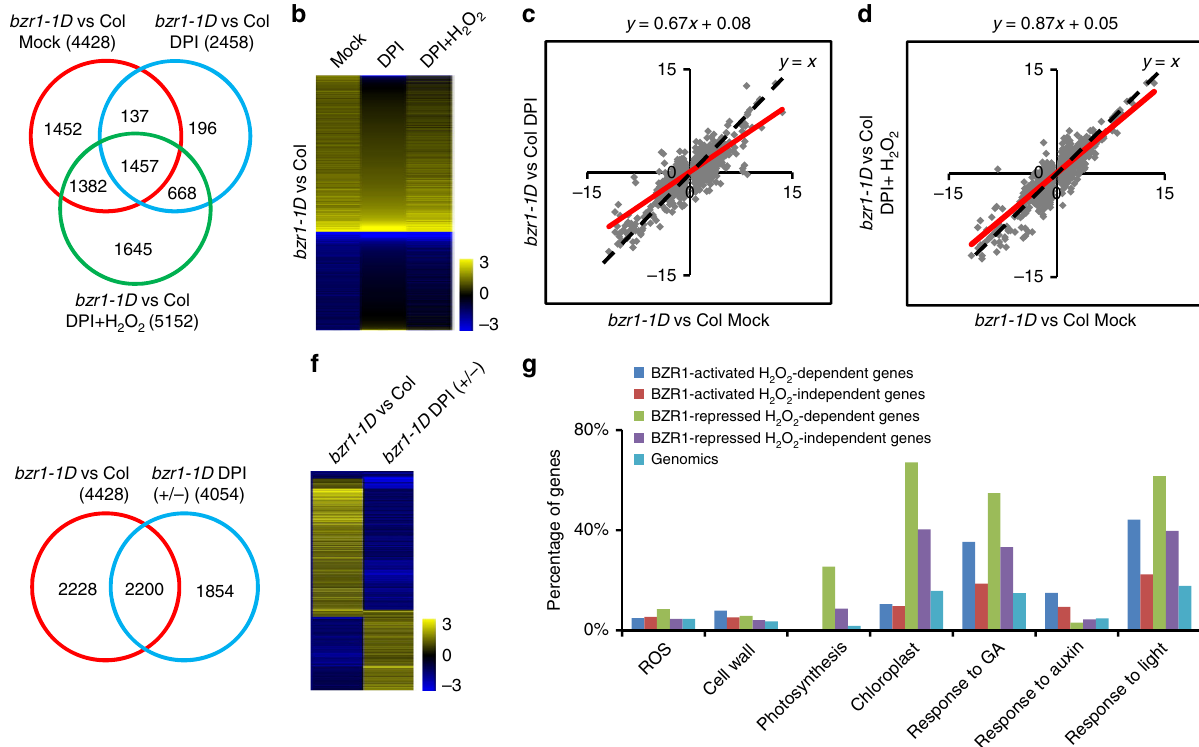
Fig. 4 The accumulation of H 2 O 2 is required for the transcriptional activity of BZR1. a The Venn diagram shows the overlap between sets of genes differentially expressed in bzr1-1D vs. Col-0 under different conditions: mock, medium containing 2 µ M PPZ; DPI, medium containing 2 µ M PPZ and 1 µ M DPI; DPI + H 2 O 2 , medium containing 2 µ M PPZ, 1 µ M DPI, and 0.3 mM H 2 O 2 . The seedlings were grown in the dark for 6 days, and then gene expression was analyzed by RNA-Seq. b Hierarchical cluster analysis of the expression data of 4428 genes regulated by BZR1 under three different conditions. The numerical values for the green-to-red gradient bar represent log2-fold change values of bzr1-1D relative to Col-0. c Scatter plot of log2-fold change values of 4428 BZR1-regulated genes in the mock condition and in the DPI condition. The red line represents the trend line of the scatter plot. d Scatter plot of log2- fold change values of 4428 BZR1-regulated genes in the mock condition and in the DPI plus H 2 O 2 condition. The red line represents the trend line of the scatter plot. e The Venn diagram shows the overlap between sets of genes regulated by BZR1 in the mock condition ( bzr1-1D vs. Col-0), and regulated by DPI in the bzr1-1D background ( bzr1-1D DPI + / − ). f Hierarchical cluster analysis of the expression of genes co-regulated by BZR1 and DPI. g Gene ontology analysis of BZR1-regulated H 2 O 2 -dependent and H 2 O 2 -independent genes. Numbers indicate the percentages of genes belonging to each GO